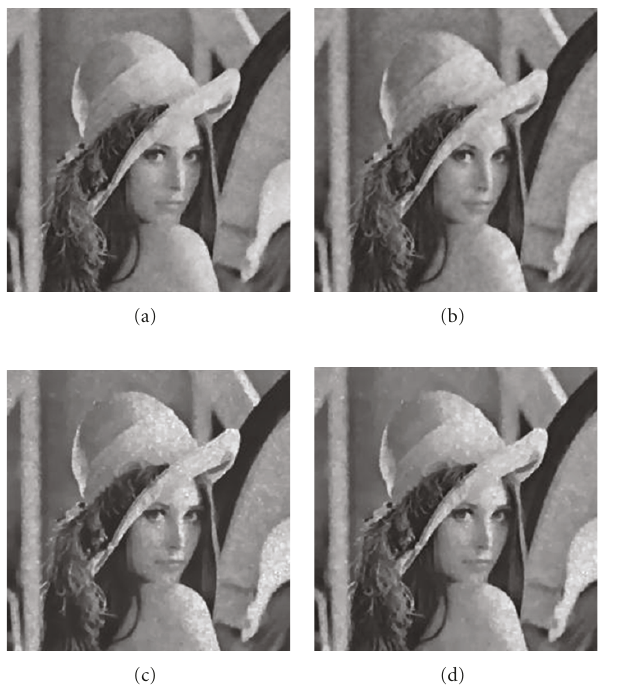
Figure 6: The restored “SynImag” images for denoising of Figure 3(a): (a) by the proposed method ( α 1 = 4 . 6 × 2 32 , α 2 = 1 . 5 × 2 32 , and ζ = 5 × 10 − 3 ); (b) by the “HMW” method ( α 1 = 0 . 01, α 2 = 0 . 01); (c) by the “AA” method; (d) by the “RLO” method.